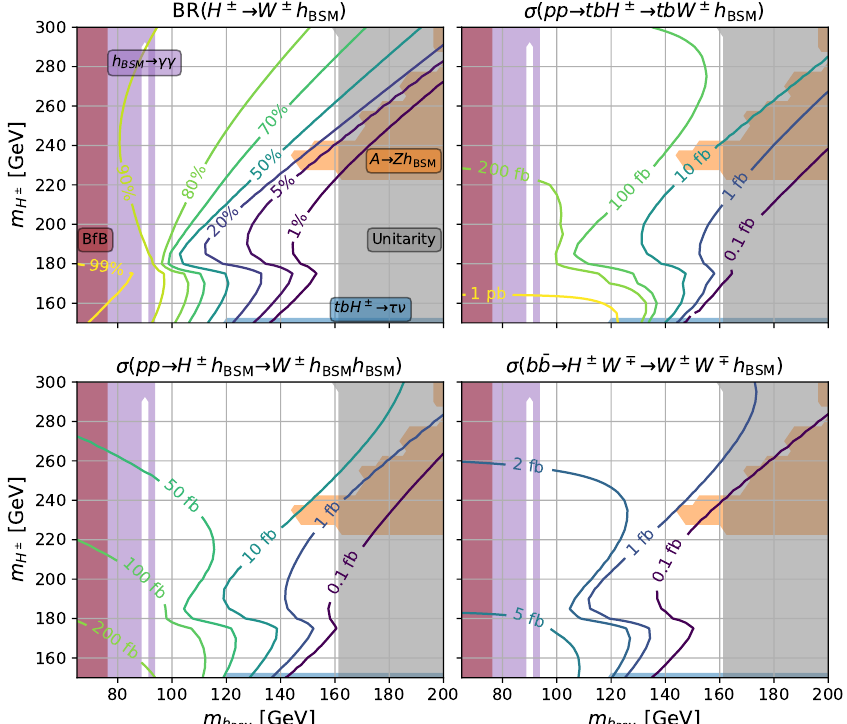
) in the ( m ) parameter plane. The col- , m h H ± BSM BSM ( top-right ), pp → H ± h ± h BSM BSM → W BSM h BSM ( bottom-right ) channels in the remaining panels. BSM